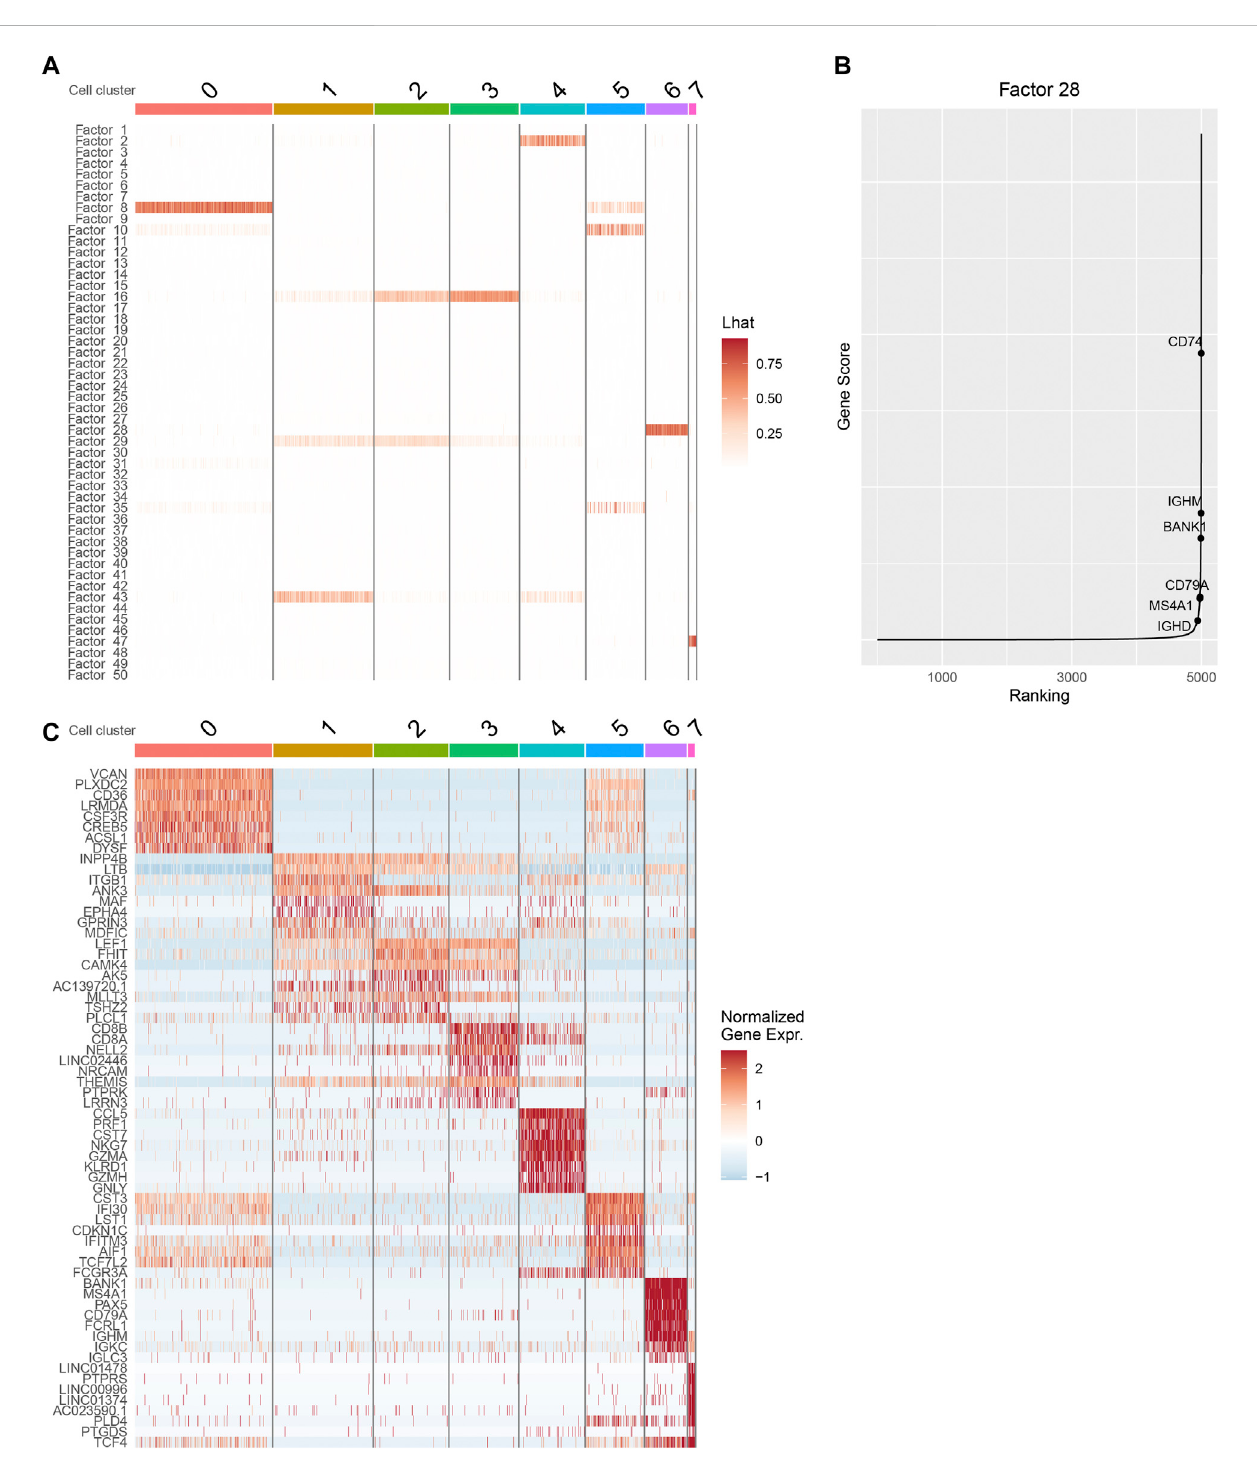
FIGURE 3 Downstream analysis with iPoLNG for 10xPBMC3k data. (A) The heatmap of the cell by factor loading matrix ^ L . The major factor score of cluster 6 is ( RNA ) allocated to factor 28. (B) Gene scores for ^ θ 28 , · , sorted in increasing order. The labelled marker genes of B cells tend to have high gene scores. (C) The heatmap for the top 8 cluster-speci fi c differentially expressed genes for each cluster. This heatmap validates the similarity of cells within and across clusters. Cells in cluster 6 tend to have high gene expression values in the canonical marker genes of B